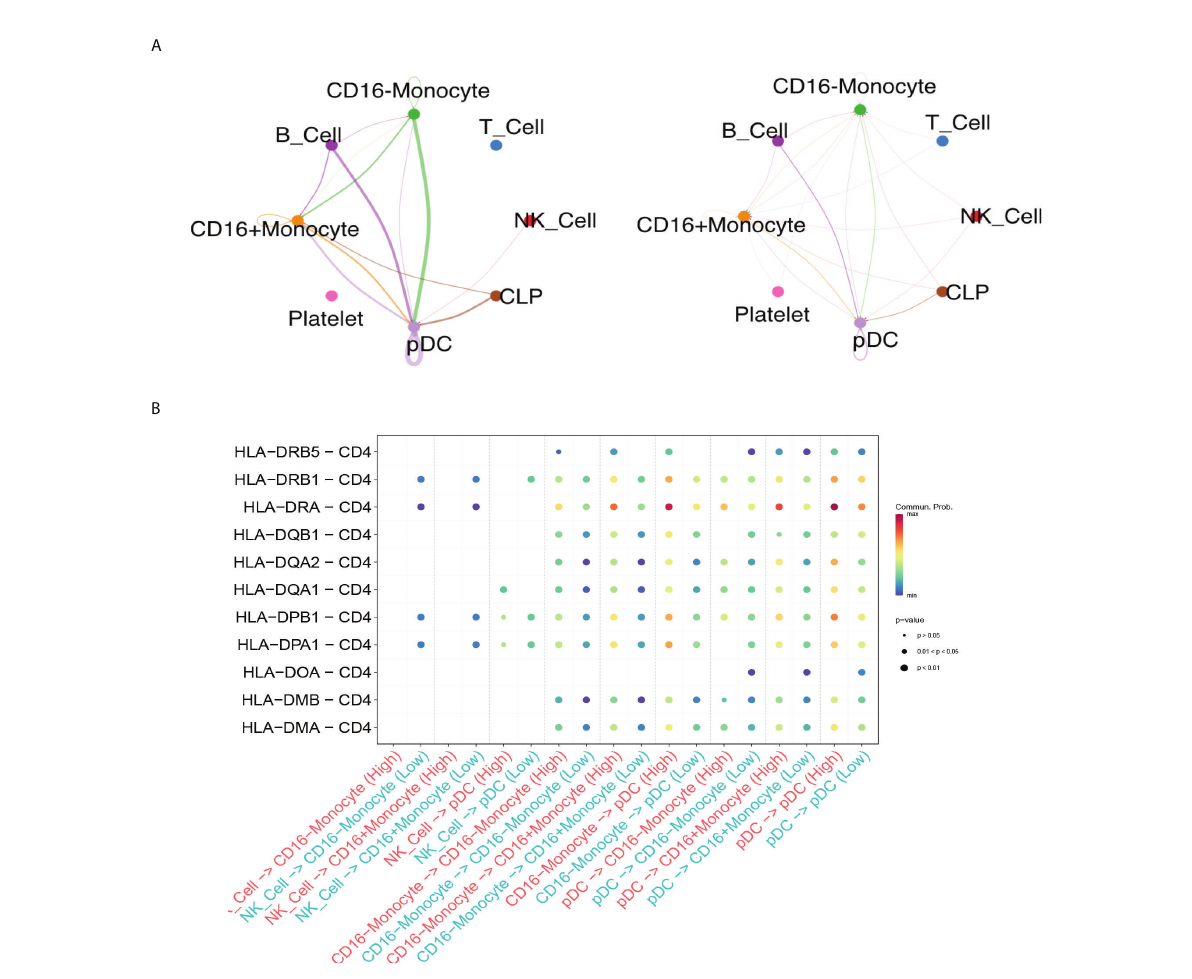
FIGURE 4 Differential crosstalks between high and low anti-SARS-CoV2-IgG antibody groups among each cell populations in rheumatoid arthritis patients. (A) Circle plot shows the MHC class II pathway outgoing and incoming signaling among high anti-SARS-CoV2-IgG antibody group (left) and low anti-SARS- CoV2-IgG antibody group (right); (B) Bubble plot shows the selected ligand-receptor interactions between NK cells, monocytes and